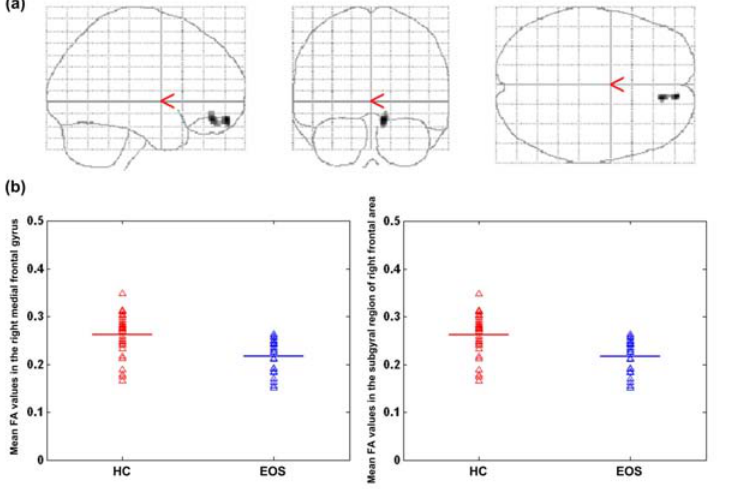
Figure 3: DTI analysis revealing significant FA differences between patients with early-onset schizophrenia and healthy controls in the right medial frontal gyrus and subgyral region of the right frontal area. (a) shows the voxels as maximum intensity projections ( P < 0.005, uncorrected; minimum cluster size = 80 mm 3 ). (b) shows mean individual FA values for healthy controls (HC) and patients with early-onset schizophrenia (EOS) in the medial frontal gyrus and subgyral region of the right frontal area, respectively.